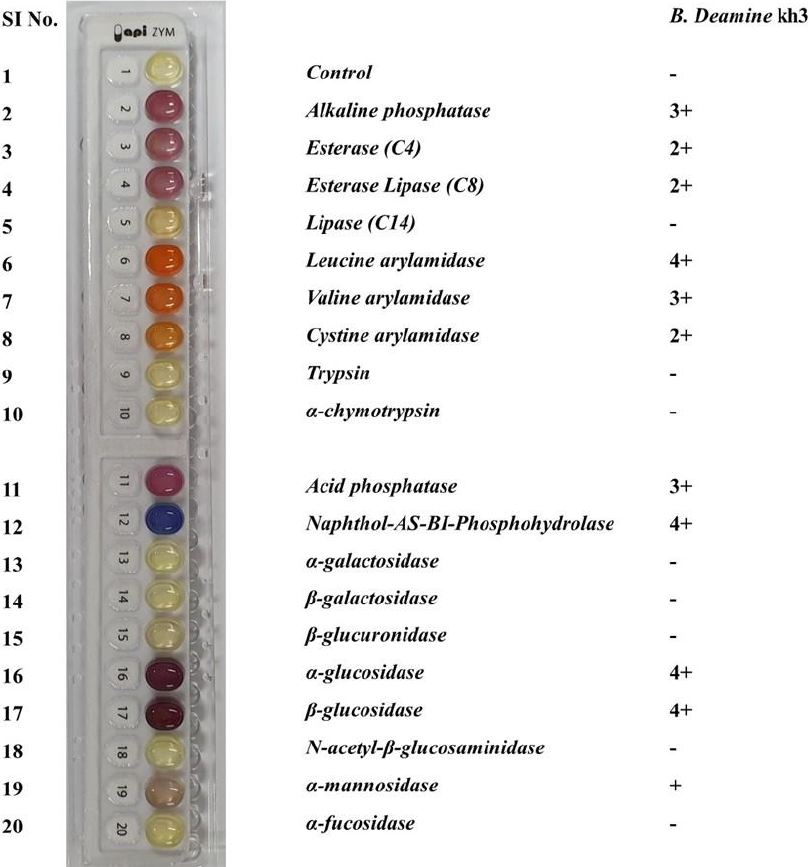
Figure 2. Enzymatic activity profile of B. deamine kh3 using a commercial assay kit. Different color developments show the activity of various enzymes with varying degrees of intensity. The B. deamine kh3 has positive activity for 11 enzymes, which were grouped as strong (from 3 to 5+) or weak (from 1 to 2+) based on the intensity of color development in their respective cupules. As can be observed in the ITS phylogenetic tree (Figure 3), the closest relative of B. deamine kh3 was B. bruxellensis with 95.5% identity , which was formed in the same clade.